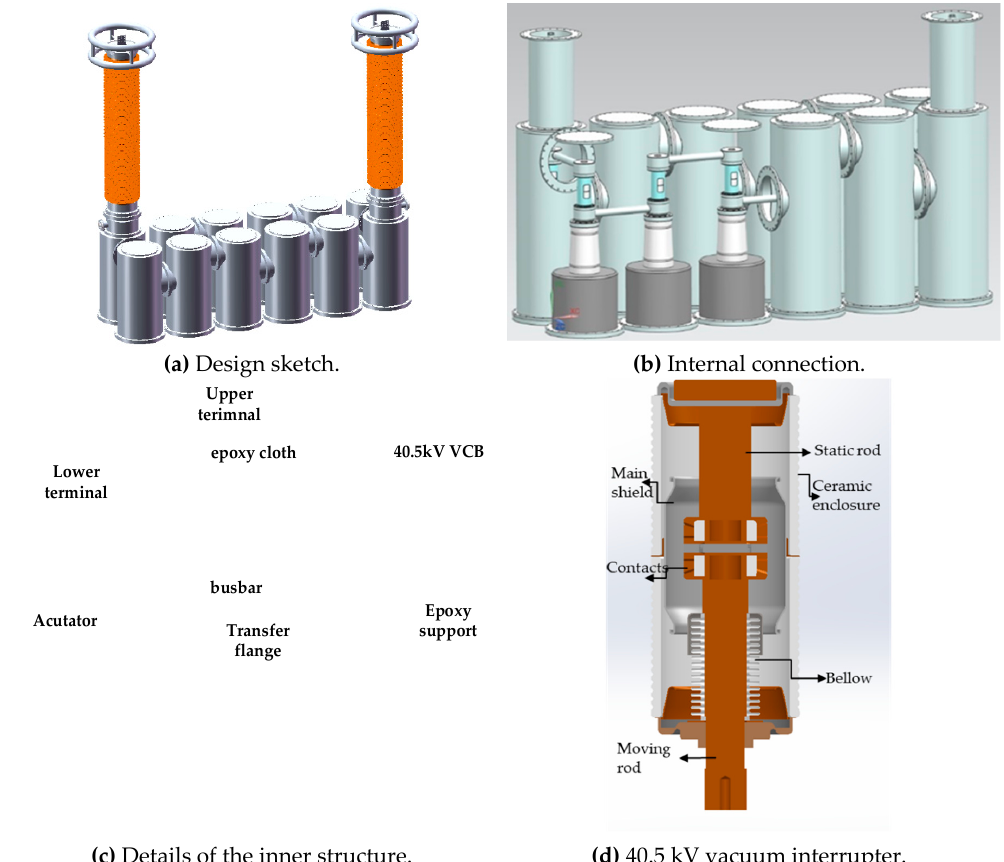
Figure 2. Single phase structure of the 363 kV VCB.